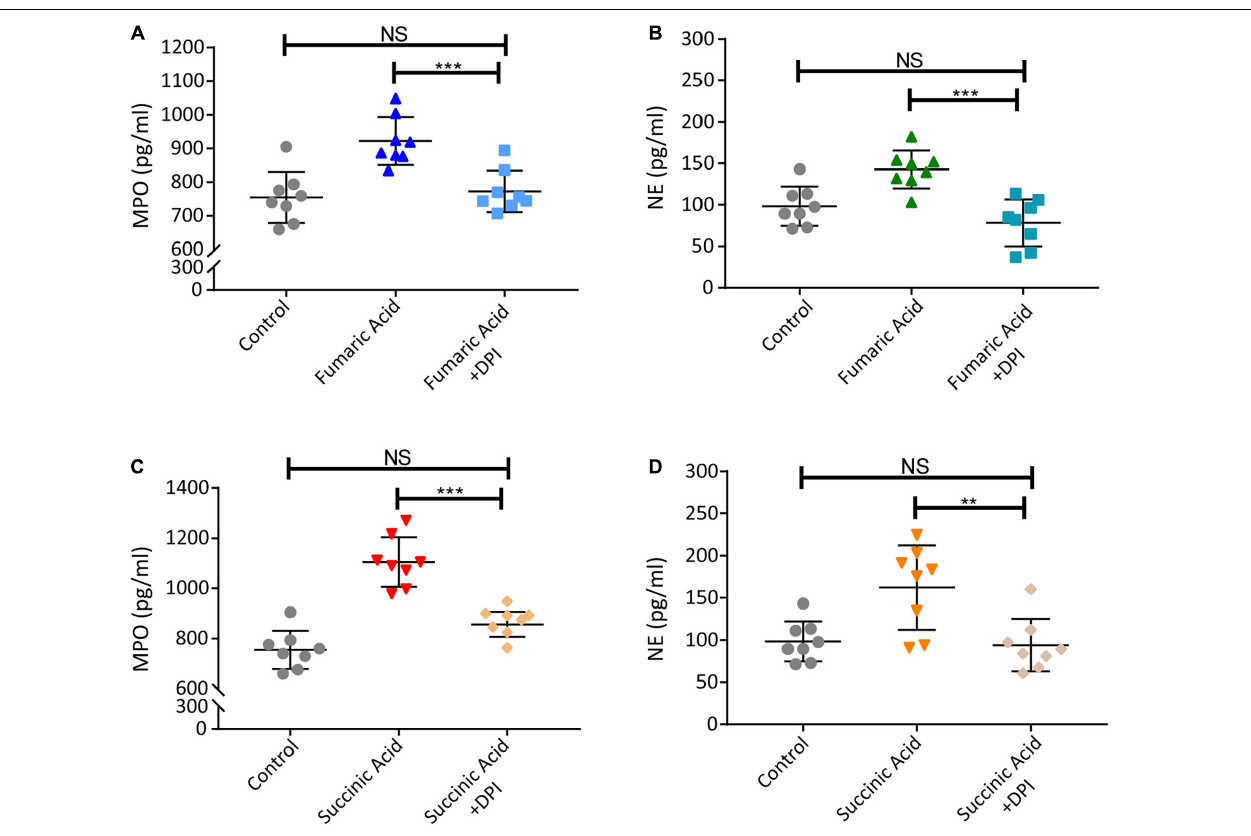
FIGURE 6 | Fumaric acid or succinic acid can induce NET formation via the NADPH oxidase-dependent pathway. (A,B) Neutrophils from normal mice were pretreated with DPI followed by the stimulation of fumaric acid. Quantification of MPO and NE in the supernatants of neutrophils. (C,D) Neutrophils from normal mice were pretreated with DPI followed by the stimulation of succinic acid. Quantification of MPO and NE in the supernatants of neutrophils ( n = 8/group; mean ± SD; *** p < 0.001, ** p < 0.01; Differences were accessed by one-way ANOVA